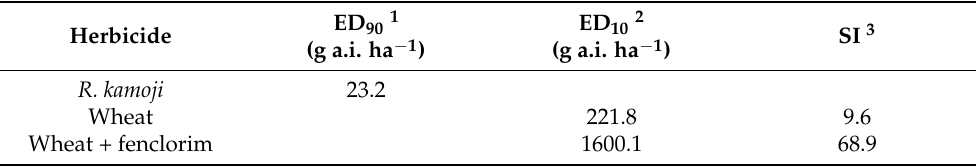
Table 3. Sensitivity of R. kamoji , wheat pre-soaking in water, and 30 mg L − 1 fenclorim solution to